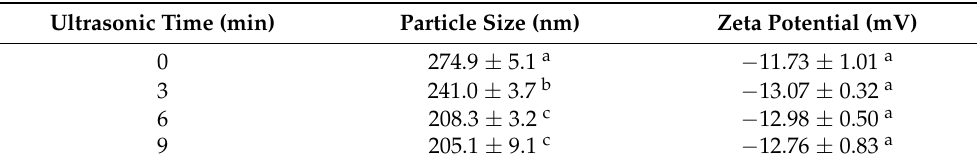
a–c : Different letters above standard deviation bars are significantly different ( p <